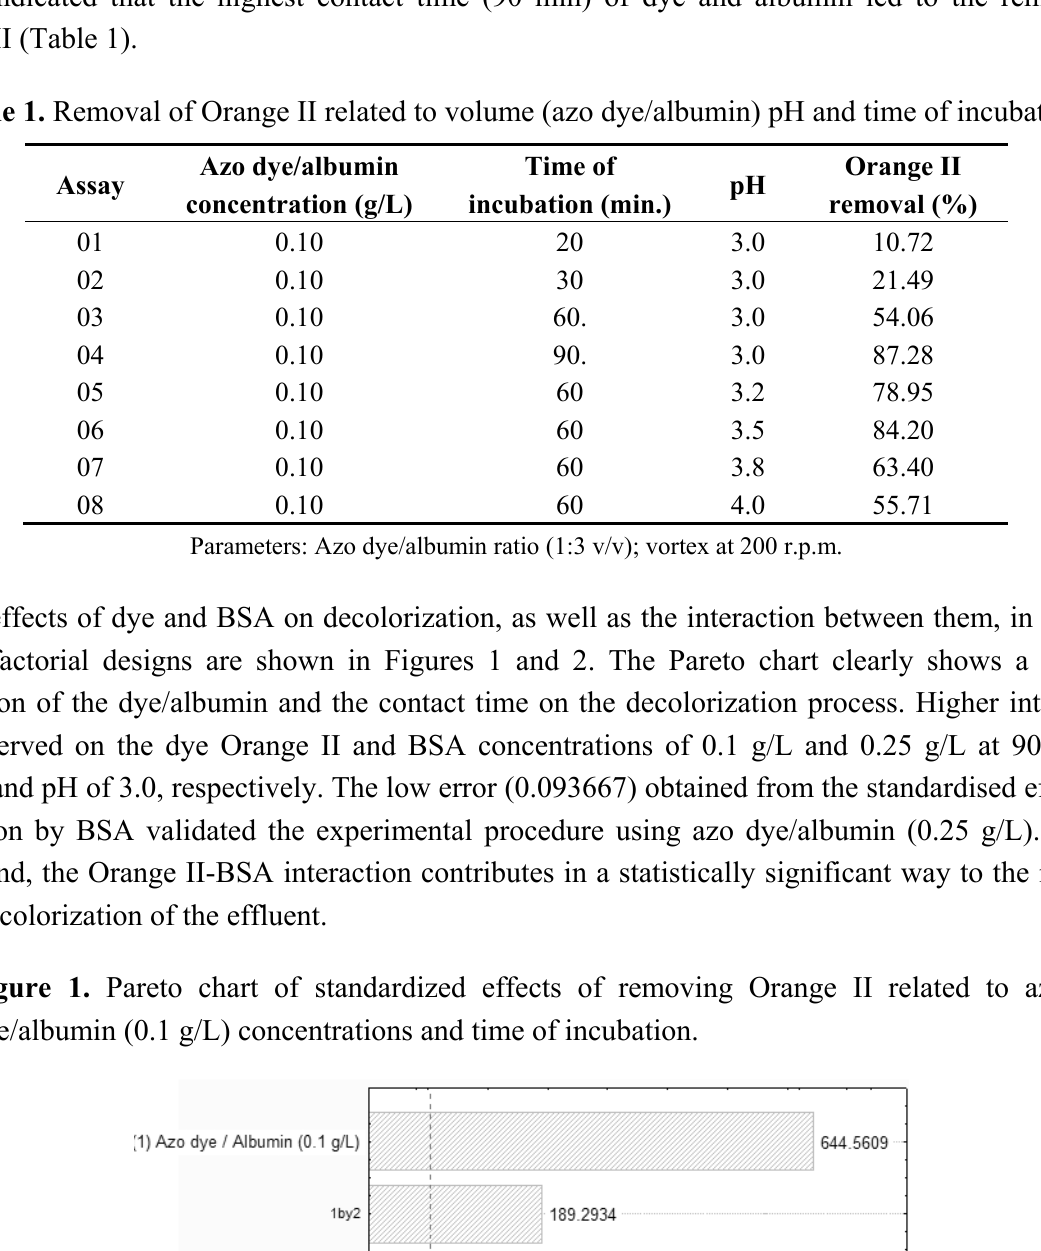
Table 1. Removal of Orange II related to volume (azo dye/albumin) pH and time of incubation. Azo dye/albumin Assay concentration (g/L) 01 0.10